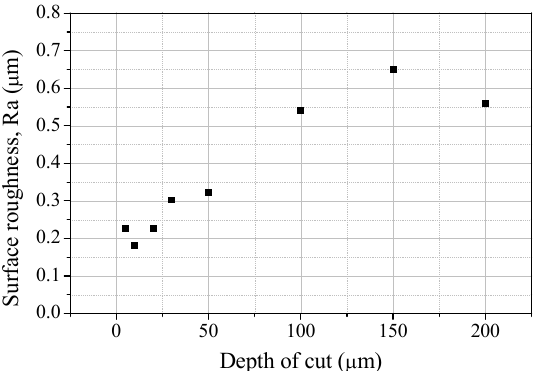
Figure 7. The surface roughness values of the channel bottoms according to the depth of cut.